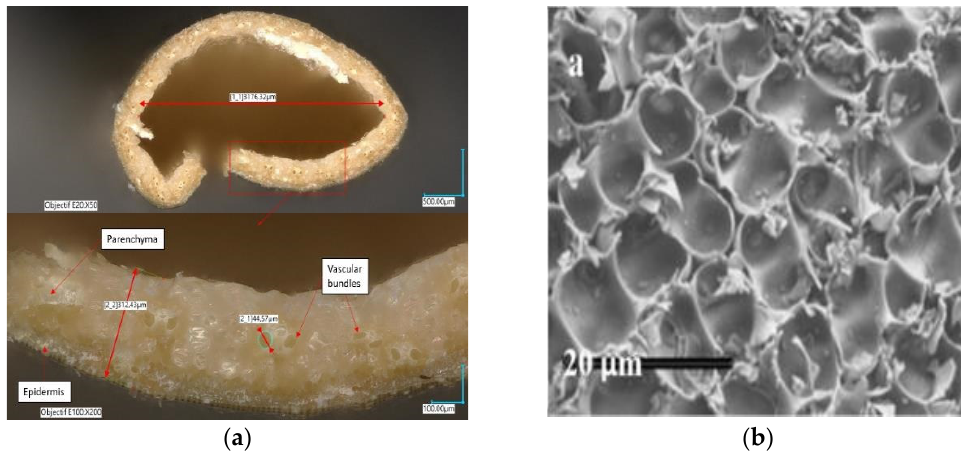
Figure 3. ( a ) Transversal cross-section of an internode wheat straw using a digital microscope. ( b ) SEM analysis of a wheat straw shell [10].